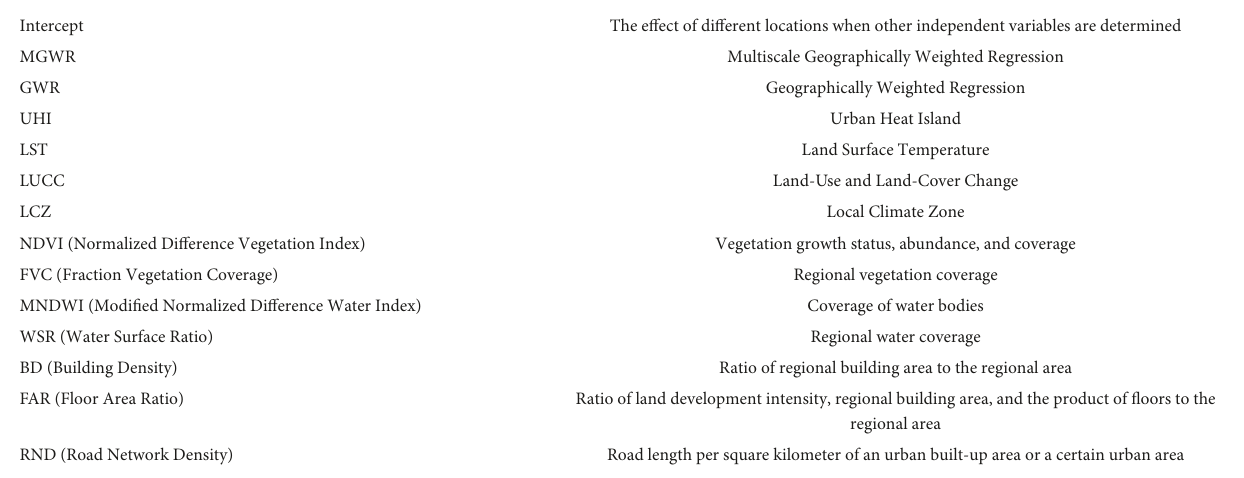
TABLE 1 List of